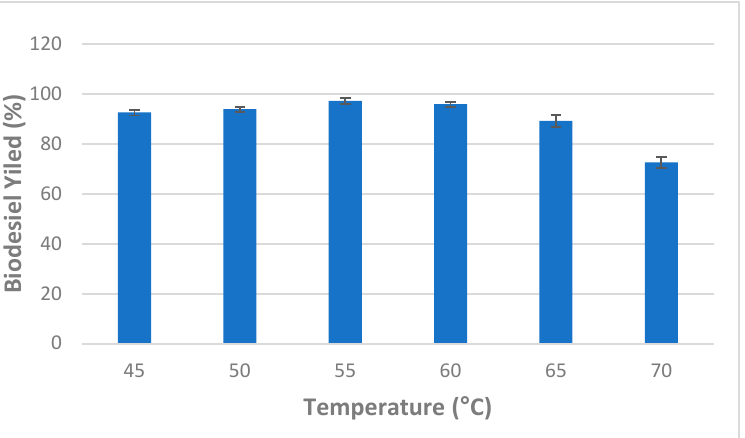
Figure 4. Effect of incubation temperature on mixed CaCO 3 -immobilized-lipase catalyzed transesterification process of waste cooking oil (WCO) for biodiesel synthesis. Experimental conditions were: methanol/oil molar ratio: 6:1, lipase loading 1%, water content 5%, reaction time 24 h, agitation speed 150 rpm. Experiments were performed in triplicate and error bars indicate mean ± standard deviation.